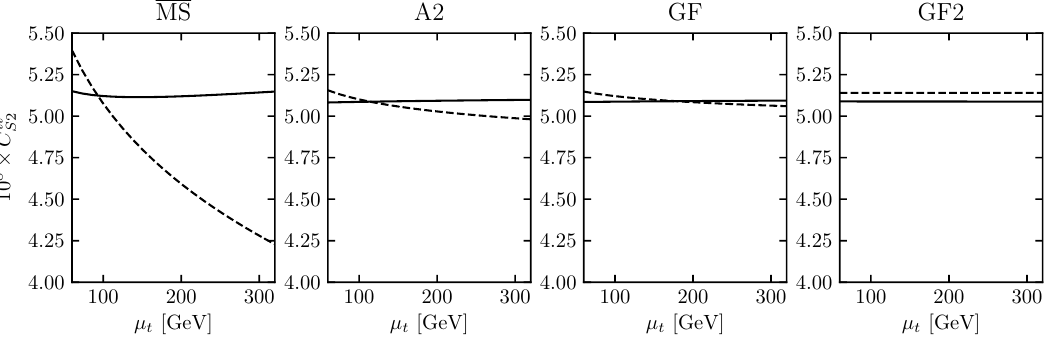
Figure 3 . Residual electroweak matching scale dependence in the MS and hybrid schemes. The dashed line shows the LO result, while the solid line show the NLO result. See text for